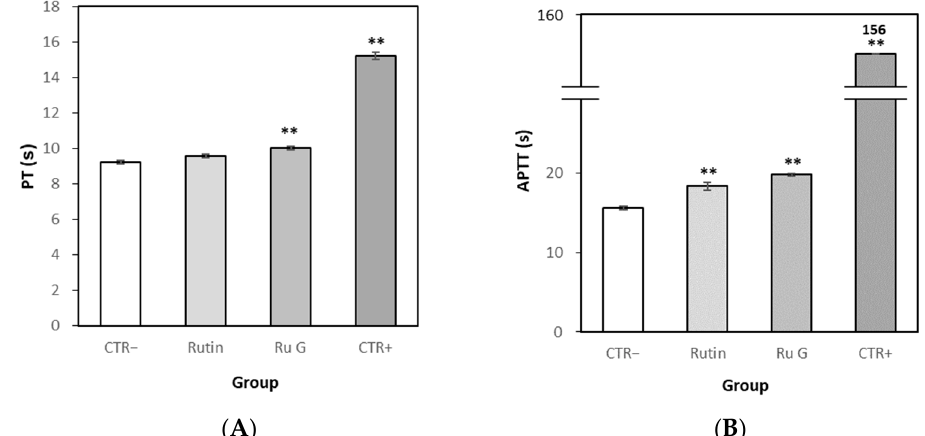
Figure 8. ( A ) Prothrombin time (PT) and ( B ) activated partial thromboplastin time (APTT) of platelet poor plasma (PPP) in vitro . Each time point represented the mean ± S.E. ( n = 3). CTR − means normal control, CTR+ means positive control (heparin), Ru G means rutin glycoside. Significant differences from the normal control group were determined via Independent t -test (** p < 0.01).